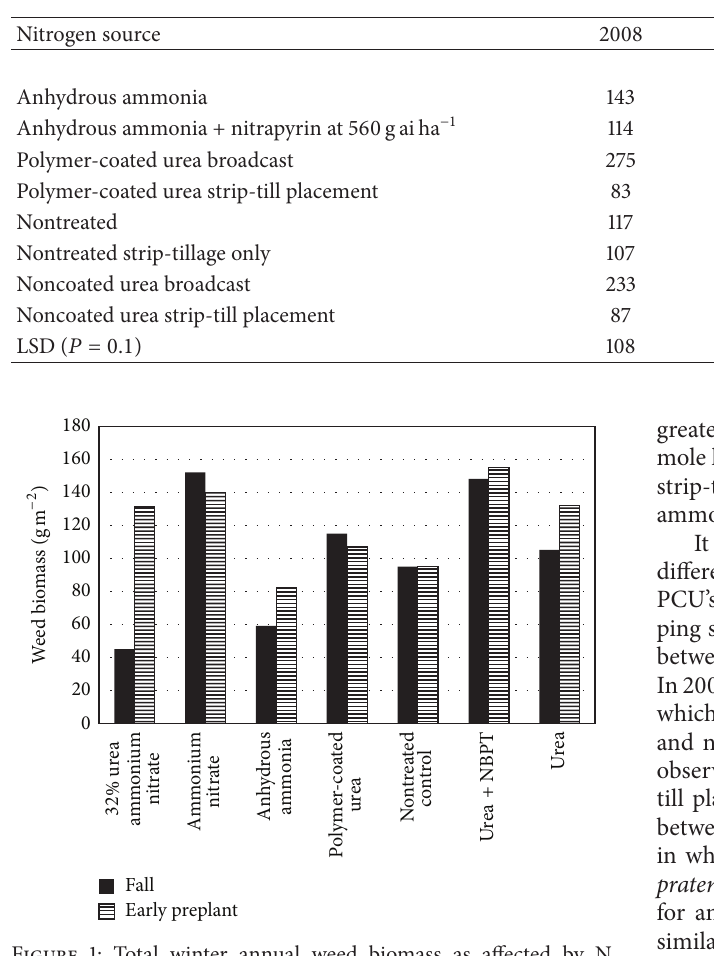
Figure 1: Total winter annual weed biomass as affected by N application sources and application timings. LSD ( 𝑃 = 0.05 ) was 45 g m −2 . Data were averaged over years. NBPT, N-(n-butyl) thiophosphoric